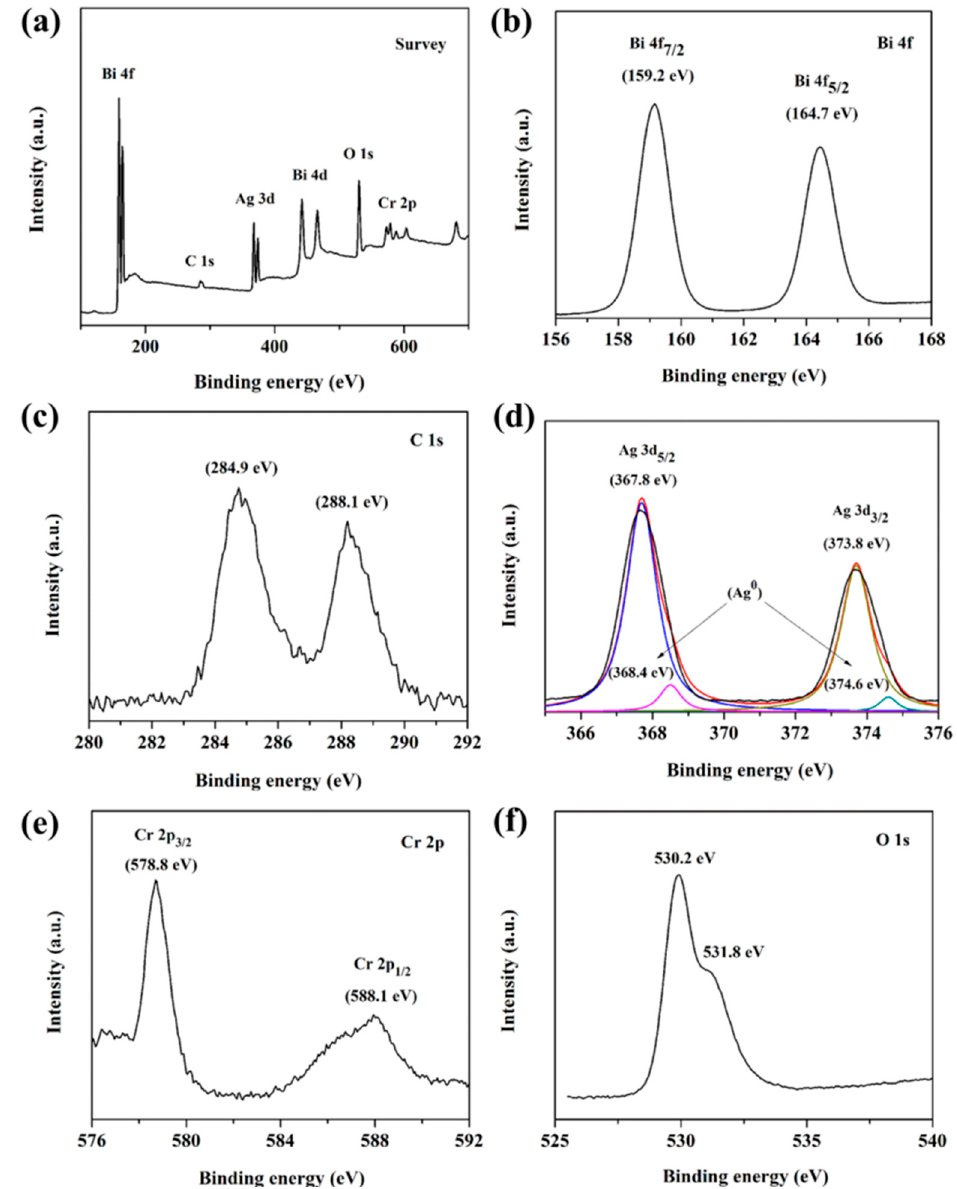
Figure 2. XPS result of Ag / Ag 2 CrO 4 / BiOCOOH: survey scan ( a ), Bi 4f ( b ), C 1s ( c ), Ag 3d ( d ), Cr 2p ( e ), and O 1s ( f ).